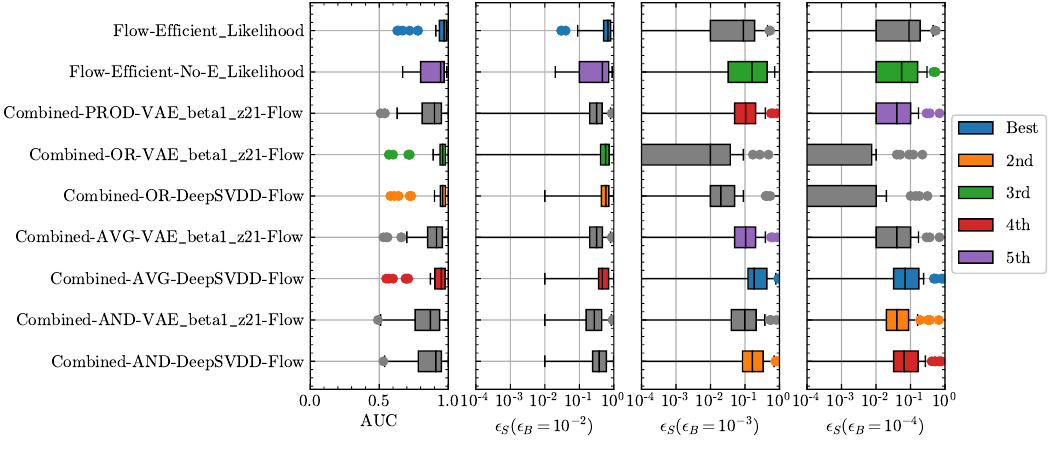
Figure 13: Box plots summarizing the anomaly detection techniques applied to all of the new physics signals. The colors denote the technique that appear in the top five scores the most